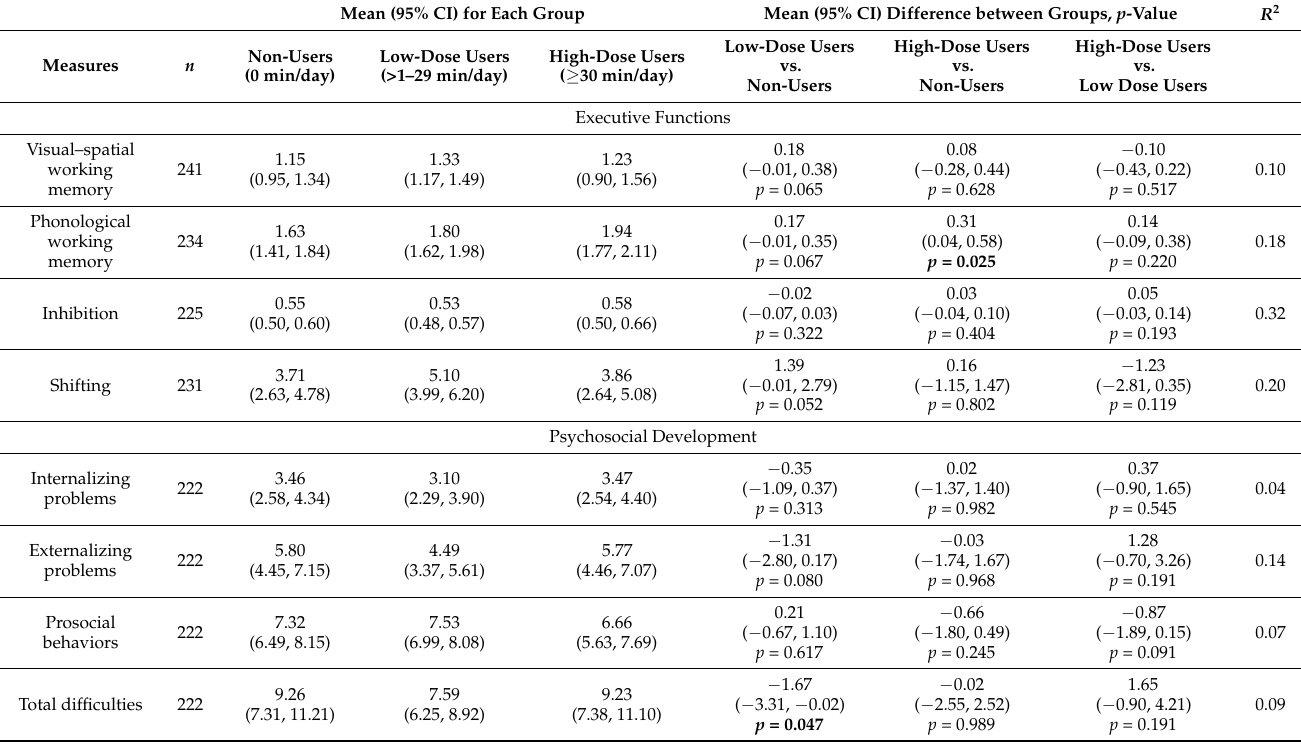
Table 3. Mean and marginal mean differences (95% confidence intervals) for associations between the dose of engagement in apps with executive functions and the Strengths and Difficulties Questionnaire (SDQ) subscales and total difficulties scores. Mean (95% CI) for Each Group Mean (95% CI) Difference between Groups, p -Value R